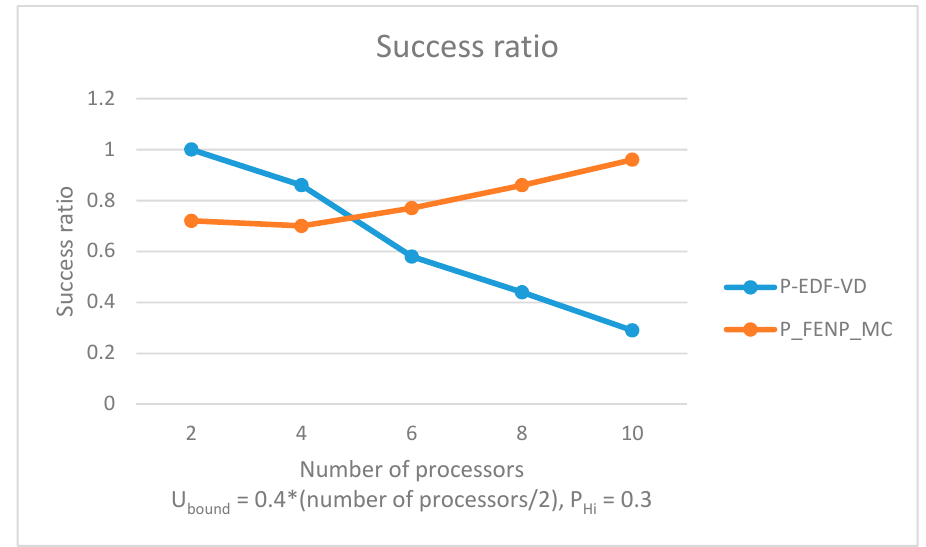
Figure 9. Success ratio by varying the number of processors. U L = 0.05, U U = 0.75, Z L = 1, Z U = 4.